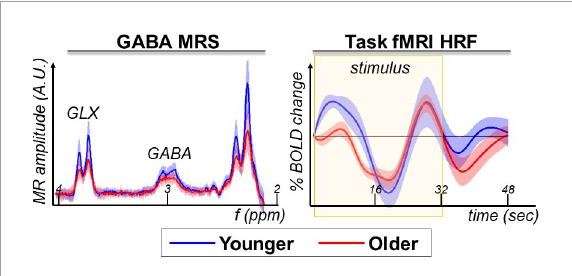
FIGURE2 GABA+ MRS and task-fMRI are the magnetic resonance modalities used in this study to assess aging-related